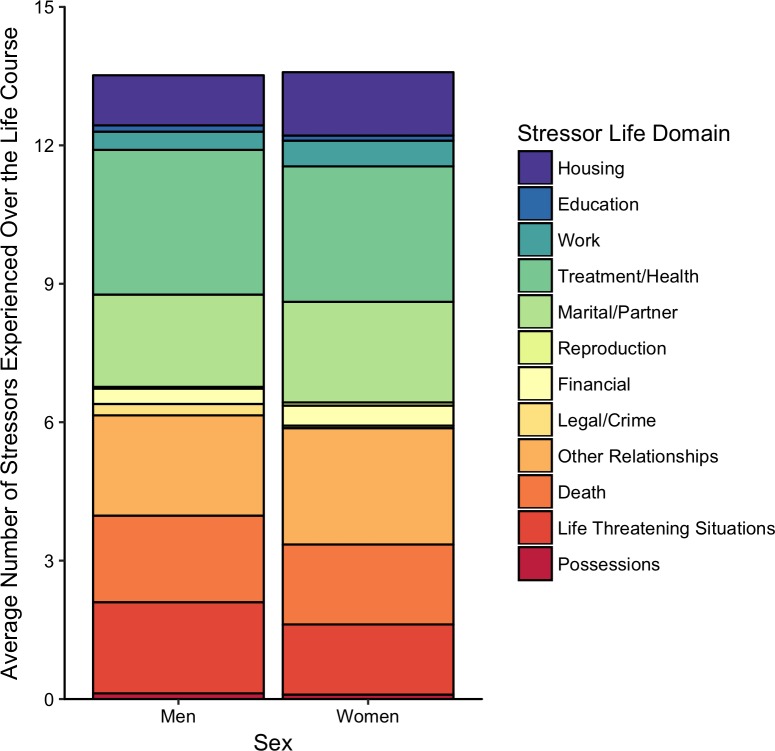
Lifetime stressor count by stressor category for men (n = 81) and women (n = 217).Stressor Life Domains: Men reported more legal/crime stressors than women (p = .005).